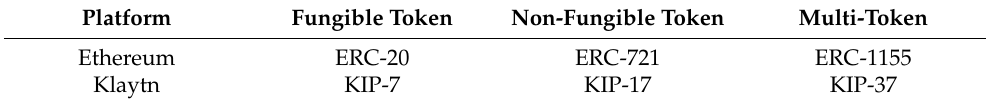
Figure 4. Sending a transaction to another EOA using an internal transaction.